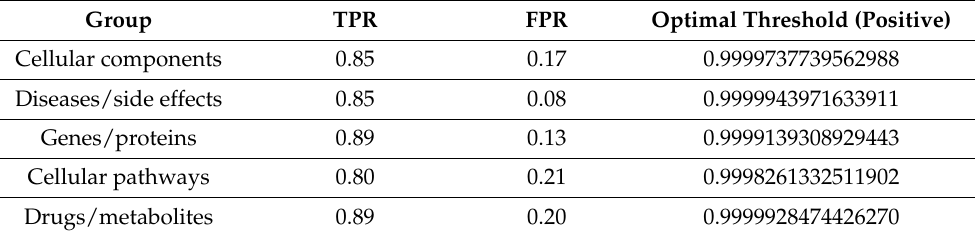
Table 1. TPR, FPR, and optimal thresholds for each classification model.